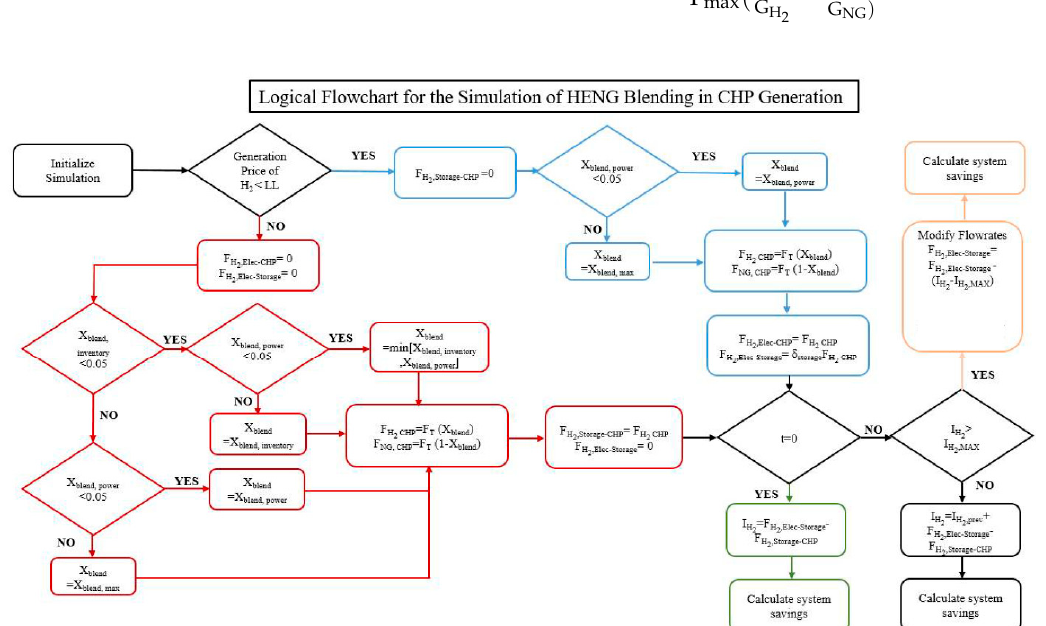
Figure 2. Outline of the simulation logic determining the amount of hydrogen to generate, produce and store within the power-to-gas system.